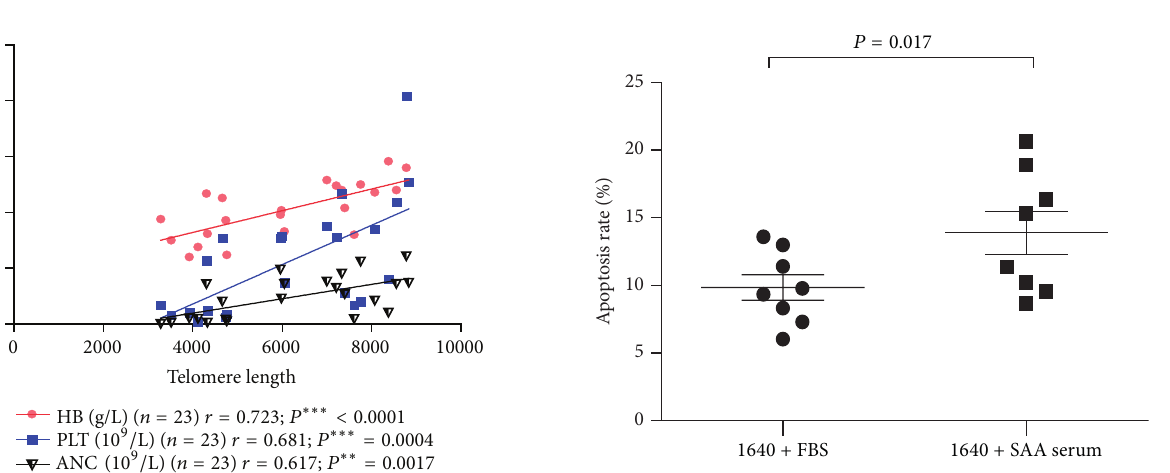
clone of paroxysmal nocturnal hemoglobinuria (PNH) cells ( 𝑟 = −0.14 , 𝑃 = 0.525 ); or the chromosomal abnormalities ( 𝑟 = −0.257 ; 𝑃 = 0.236 ).